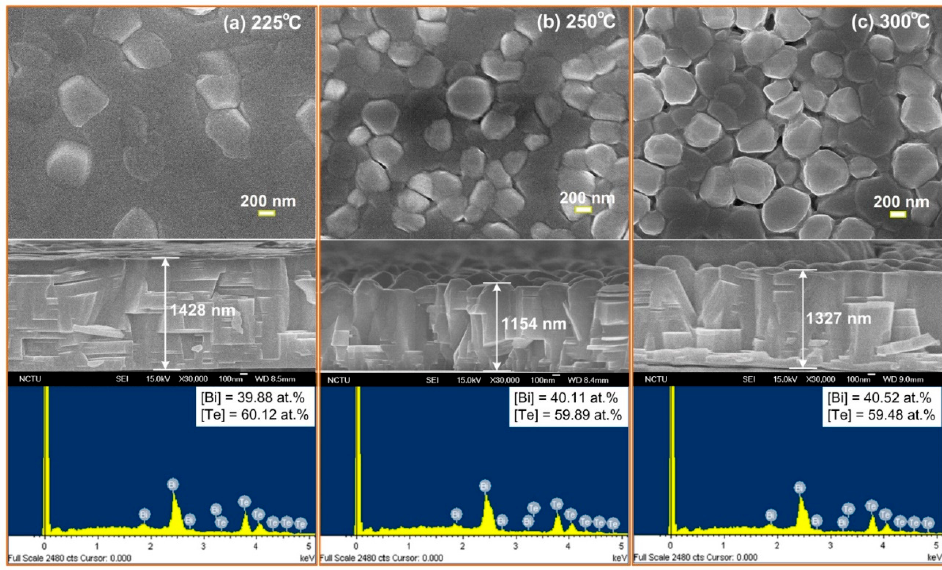
Figure 3. SEM images (upper: top view and middle: cross section) and EDS spectra of the Bi 2 Te 3 thin films deposited at various substrate temperatures of 225, 250, and 300 °C.